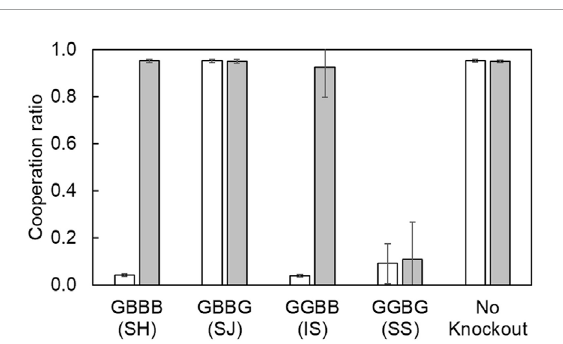
FIGURE 2 Results of pioneer norms analysis and keystone